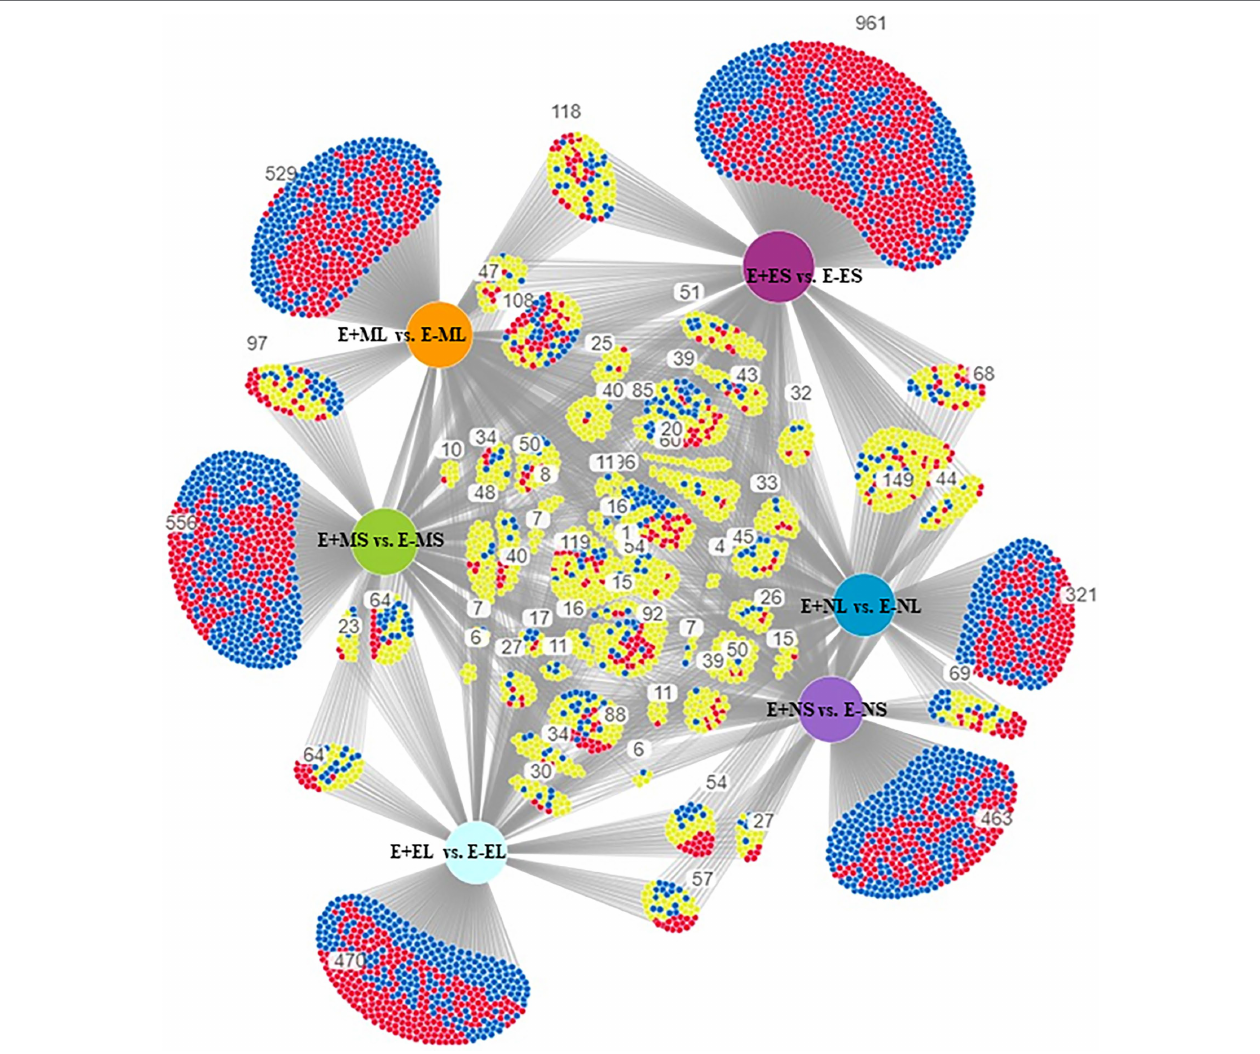
FIGURE 2 | Visualization of differential gene expression pattern among E+MS vs. E − MS, E+ML vs. E − ML, E+NS vs. E − NS, E+NL vs. E − NL, E+ES vs. E − ES, and E+EL vs. E − EL using DiVenn program. The red and blue nodes represent up- and downregulated genes, respectively. The yellow node represents upregulated in one dataset but downregulated in the other dataset. Abbreviations of the samples are the same as in Figure 1